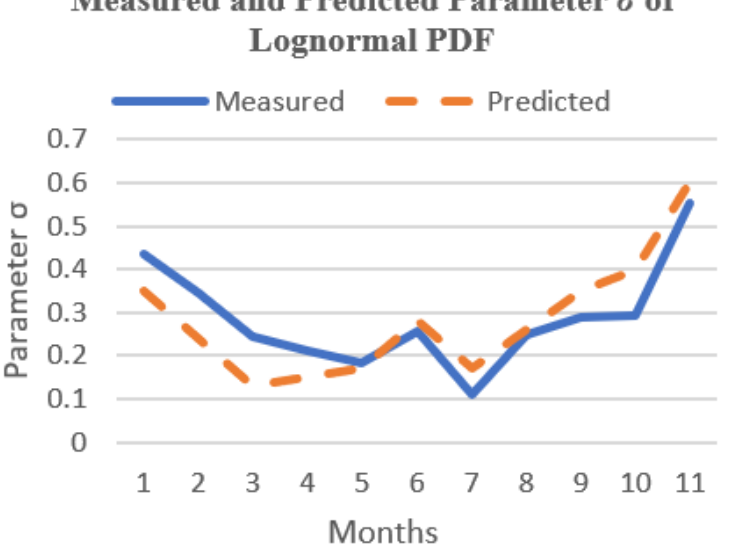
Figure 10. Predicted parameter σ of the Lognormal PDF.